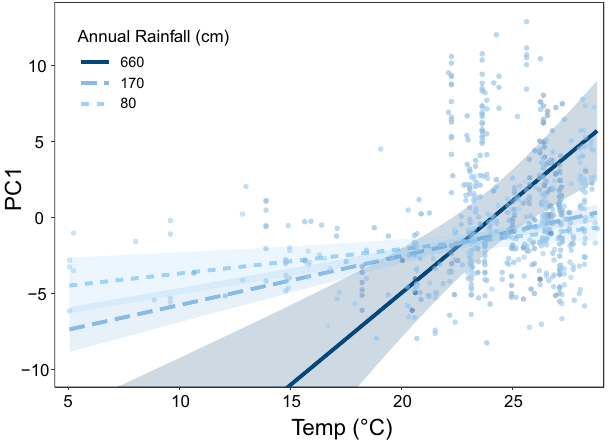
Figure 4. A plot depicting the positive interaction between average annual temperature and annual total rainfall in a linear model predicting body size (PC1) (Supplementary Table S4). Regression lines are displayed at the approximate minimum, median, and maximum rainfall values and plotted with 95% confidence